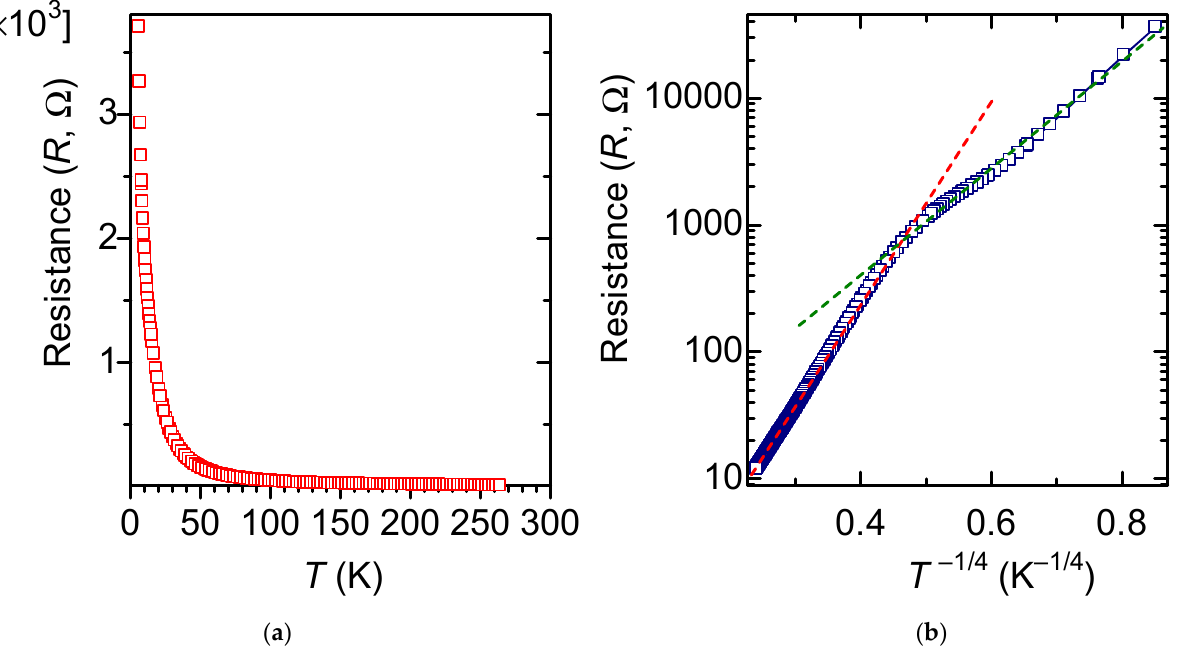
Figure 12. ( a ) Resistance ( R ) of V-CB(PANI) as a function of temperature ( T ); ( b ) R (ln R ) of V-CB(PANI) as a function of T − 1/4 . This result indicates the occurrence of the 3-dimensional variable range hopping (3D- VRH) of electrons in the V-CB(PANI) at low and high-temperature ranges [23,24]. Further, the 1/ R value of V-CB(PANI) was proportional to T at > 40 K as a semiconductor tendency (Figure 13). Low-temperature range in 1/ R vs. T plots corresponds to the green dotted line in Figure 12b. The two ranges of 3D-VRH in Figure 12b, suggest that intra-molecular electron hop- ping is responsible for electrical conduction at high temperatures in addition to intra-mo- lecular electron hopping (Figure 14).